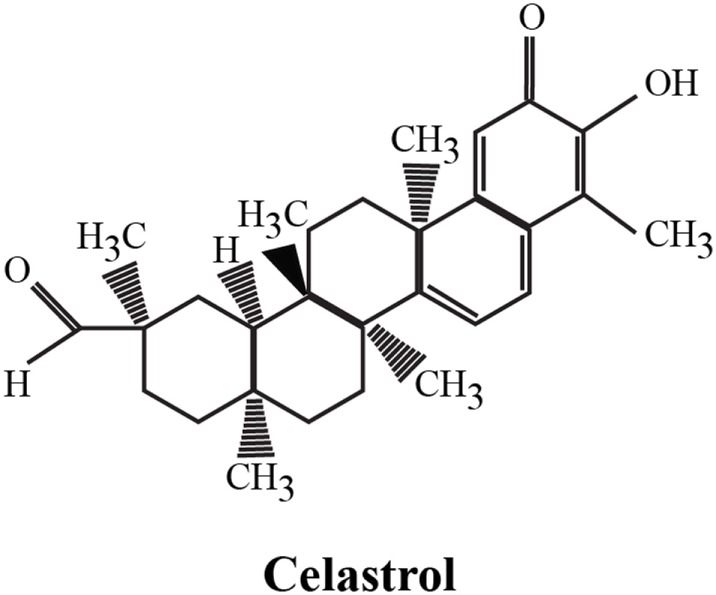
Chemical structure of celastrol. The chemical formula of celastrol is C29H38O4 [adapted from Ref. (1)].